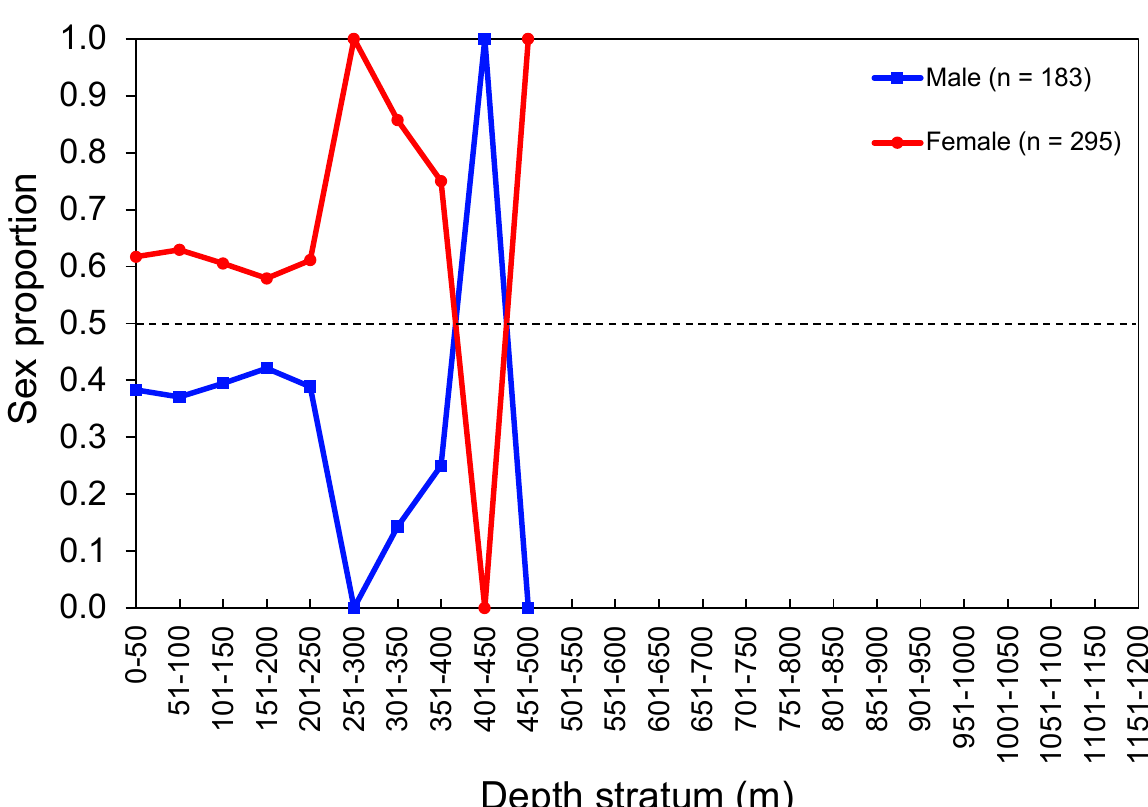
Figure 6. Sex proportion of the thornback ray Raja clavata by depth stratum. Data from the scientific surveys in the Azores. The number of individuals (n) refers to the total number of sampled thornback rays. The dashed line shows an equal sex ratio.